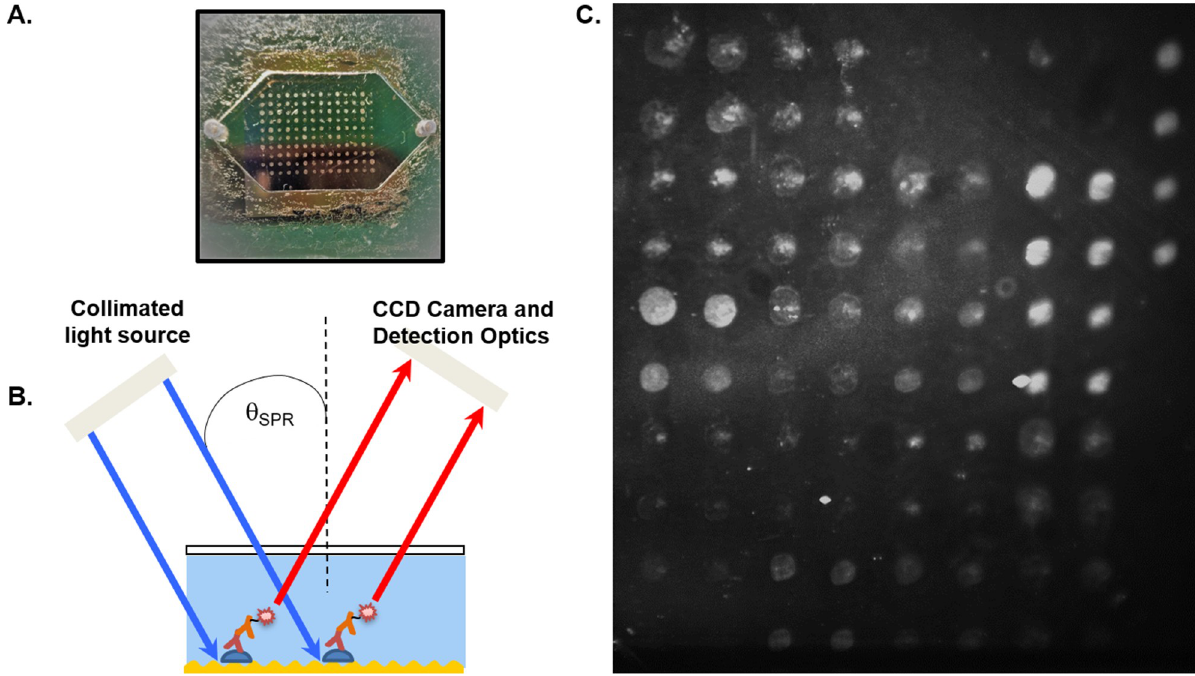
Fig 1. The GC-FP platform and its linear range of IgG antibody detection. (A) After being coated with antigens, a GC-FP biochip is assembled with a gasket and window to form a microfluidic chamber, where serum samples and other reagents can be applied. (B) GC-FP analysis on the gold-coated biochip involves using a fluorophore-labelled secondary antibody that couples with the surface plasmon field to emit enhanced fluorescent signal. (C) A representative GC-FP image is shown, containing various LD targets. The fluorescence intensity at each spot ROI corresponds to the amount of detected